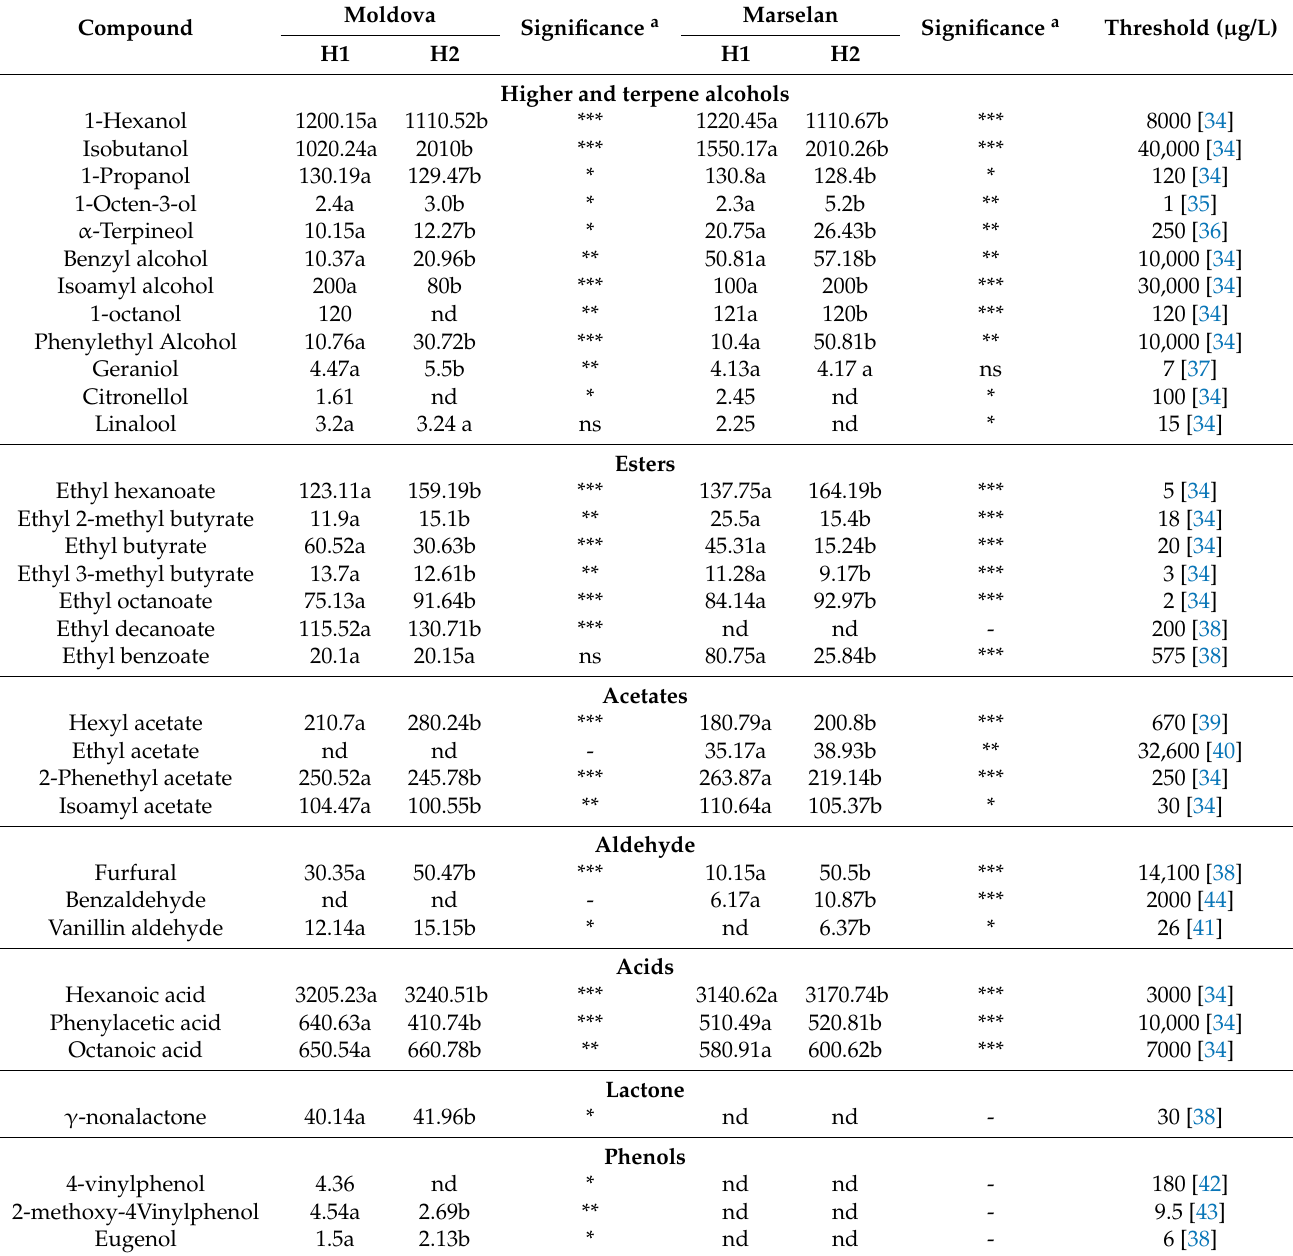
Table 6. Quantitative data of aromatic compounds in Moldova and Marselan icewines.